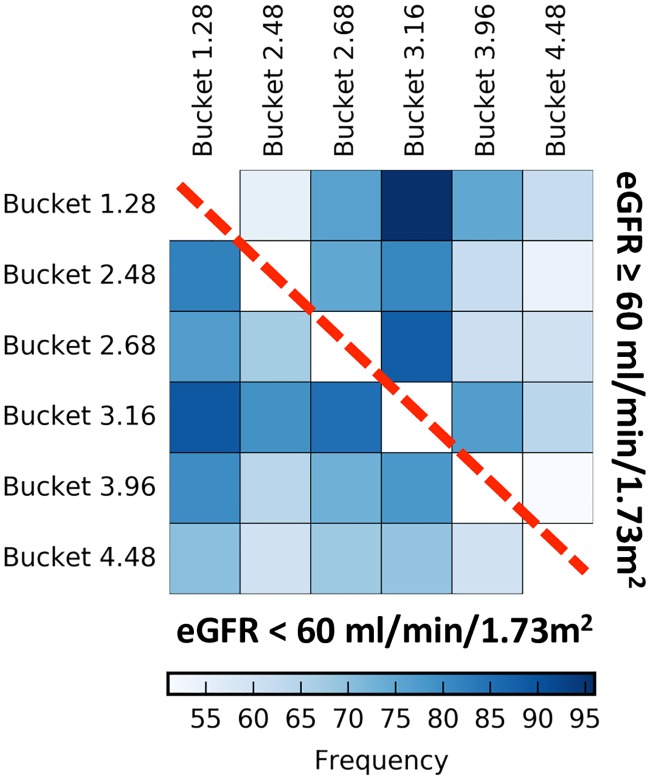
Frequency of the cluster of buckets present in at least 50% of the local 1&2D models.This figure shows the frequency heatmap of the interactions (color scale) of each bucket pair of the cluster over the 100 local 1&2D models. The more robust the interaction is, the darker it will be. The interactions corresponding to the subgroup of patients with an eGFR < 60 ml/min/1.73m2 are displayed in the lower triangle and conversely, the interactions corresponding to the subgroup of patients with an eGFR ≥ 60 ml/min/1.73m2 are displayed in the upper triangle. The limit of the two triangles is represented by the red dashed-line.